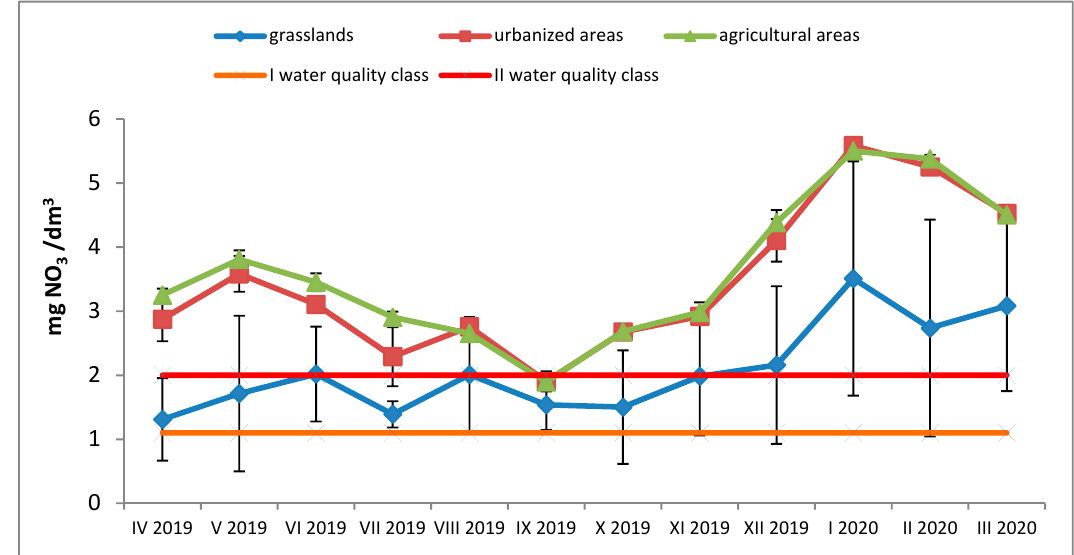
Figure 4. Mean and standard deviation for nitrates in the water as a function of sampling date and catchment area land use.